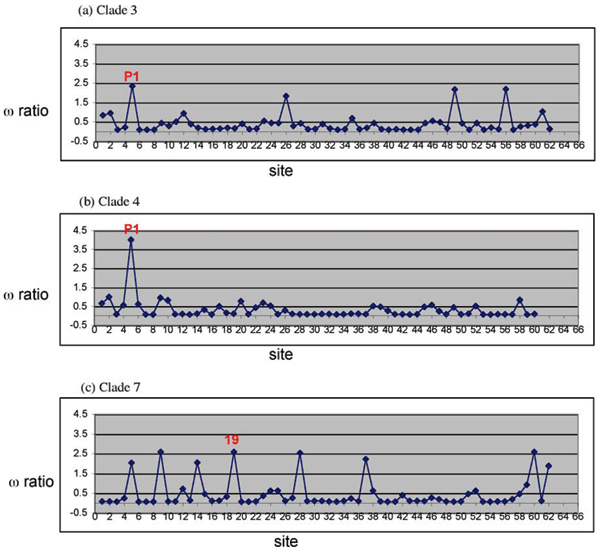
Approximate posterior mean of the ω ratio for each site calculated under model M8. The values were estimated by Bayes Empirical Bayes (BEB) method for (a) Clade 3 (1st RUs of 2-RU or 3-RU PIs); (b) Clade 4 (2nd RUs of 2-RU or 3-RU PIs); (c) Clade 7 (Similar RUs of multi-RU PIs from Nicotiana genus).